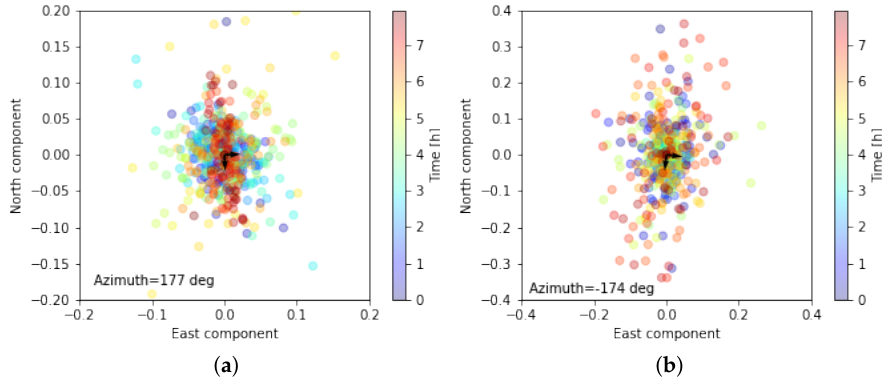
Figure 14. LOFAR amplitudes for 3 min central period for ( a ) L82655 and ( b ) L79324. Color scale shows time from the start of observation. Black arrows indicate the dominant directions calculated from Principal Components Analysis (PCA), with the azimuth value provided for the direction explaining majority of